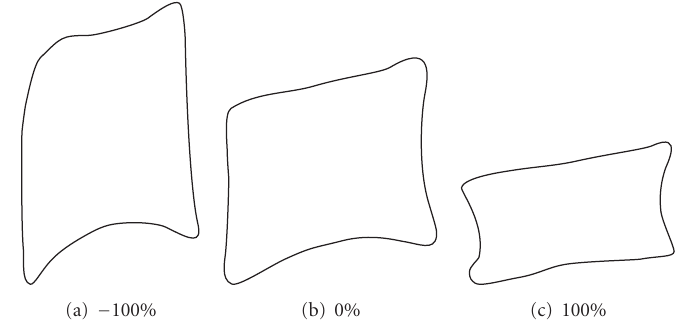
Figure 15: E ff ects of variations along the principal directions of a vertebra